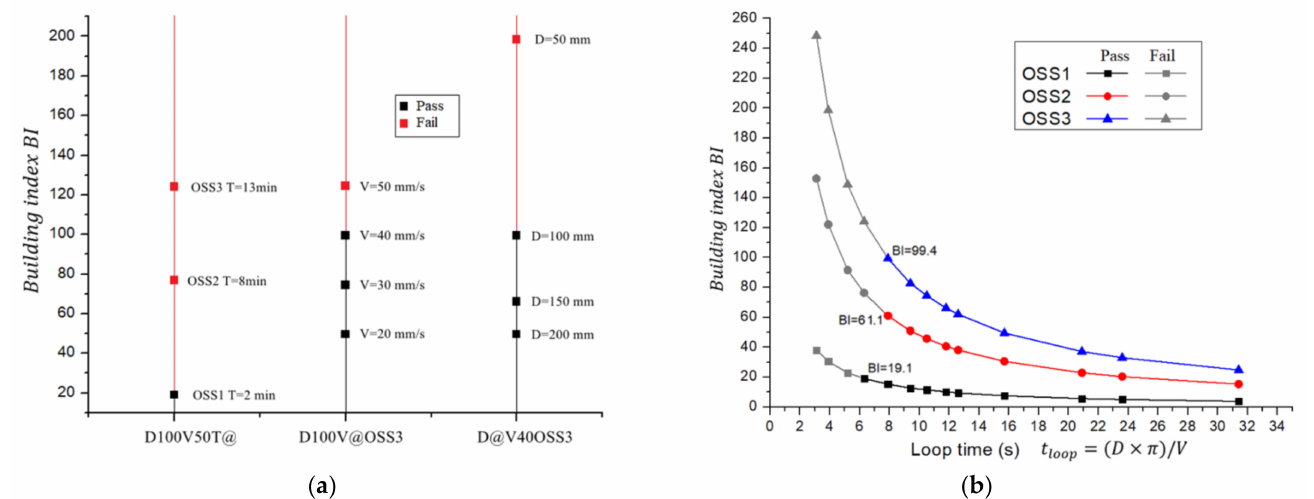
Figure 12. The BI results. ( a ) Results separately based on initial setting time group D100V50T@, print- ing speed group D100V@OSS3, and cylinder diameter group D@V40OSS3, and ( b ) the relationship between BI and the loop time t loop , based on different initial setting time